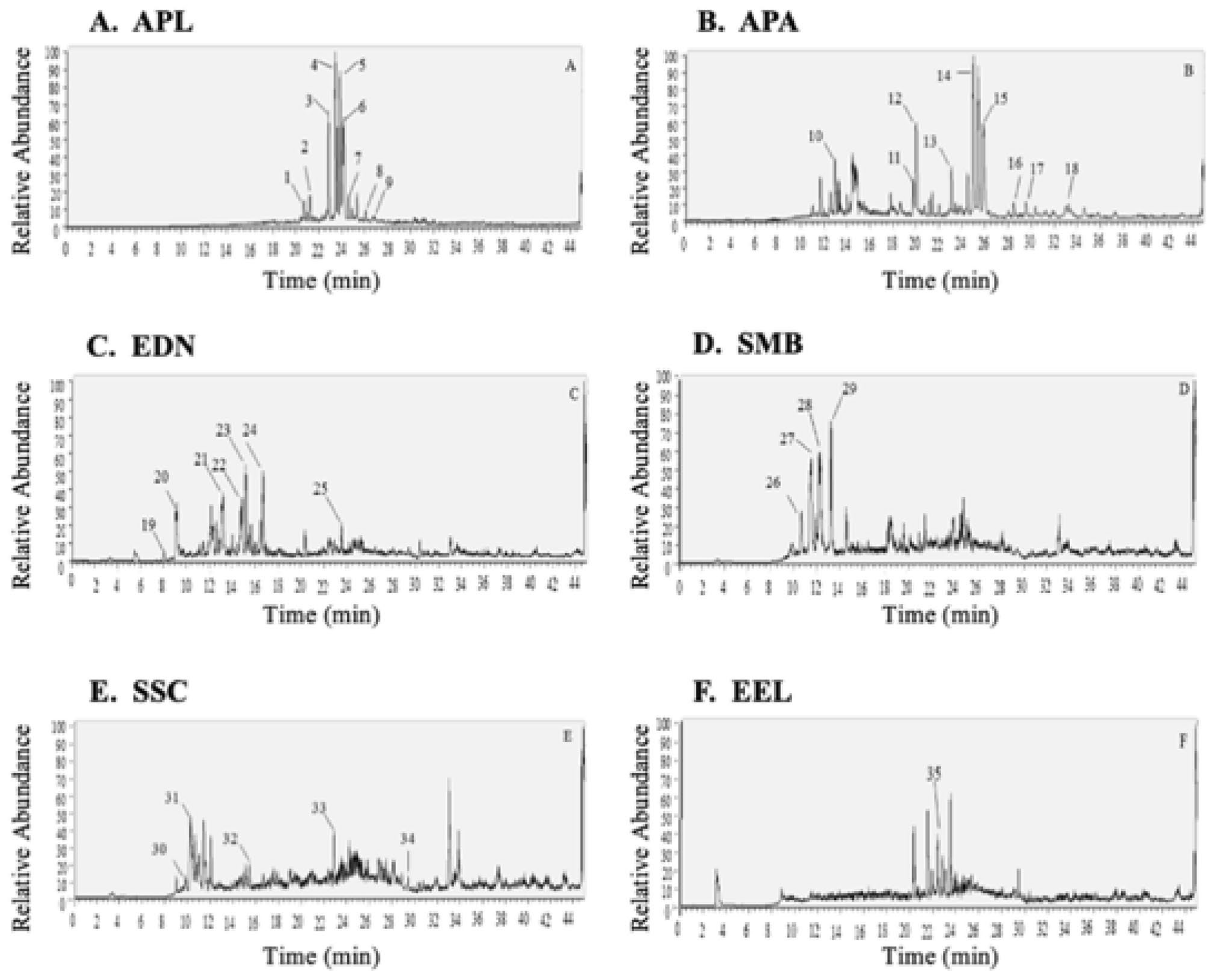
Figure 12. Preliminary phytochemical screening of Mauritius selected endemic plants: This was determined using LC–MS chromatography in positive mode. ( A ) represents plant extract of Psiadia lithospermifolia , ( B ) represents plant extract of Psiadia arguta , ( C ) represents plant extract of Diospyros nodosa ( D ) Mimusops balata ( E ) Sideroxylon cinereum and ( F ) Erythroxylum laurifolium